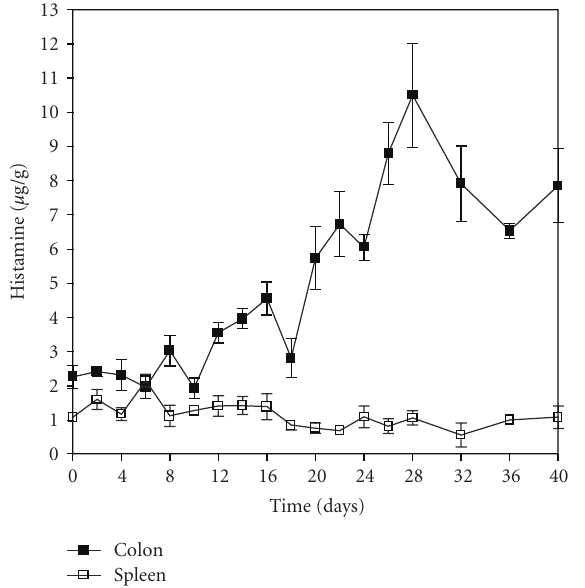
Figure 1: Histamine concentration in colon and spleen of Wistar rats with colitis induced by TNBS. The results are expressed as mean ± SEM ( n = 6).